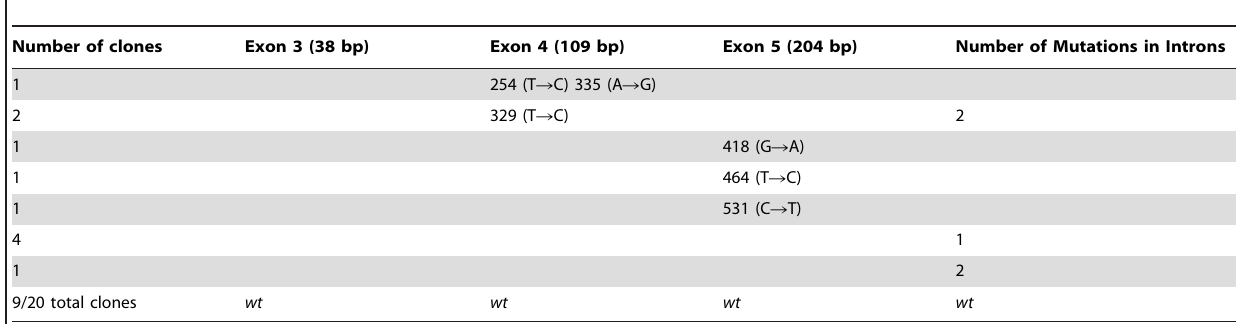
Each clone was sequenced on both filaments. Numeration of nucleotide positions of exons starts from A of the initial ATG triplet of the coding sequence. wt : wild type